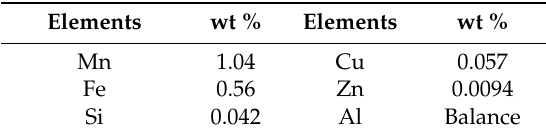
Table 1. Chemical compositions of 3003 aluminum alloy.